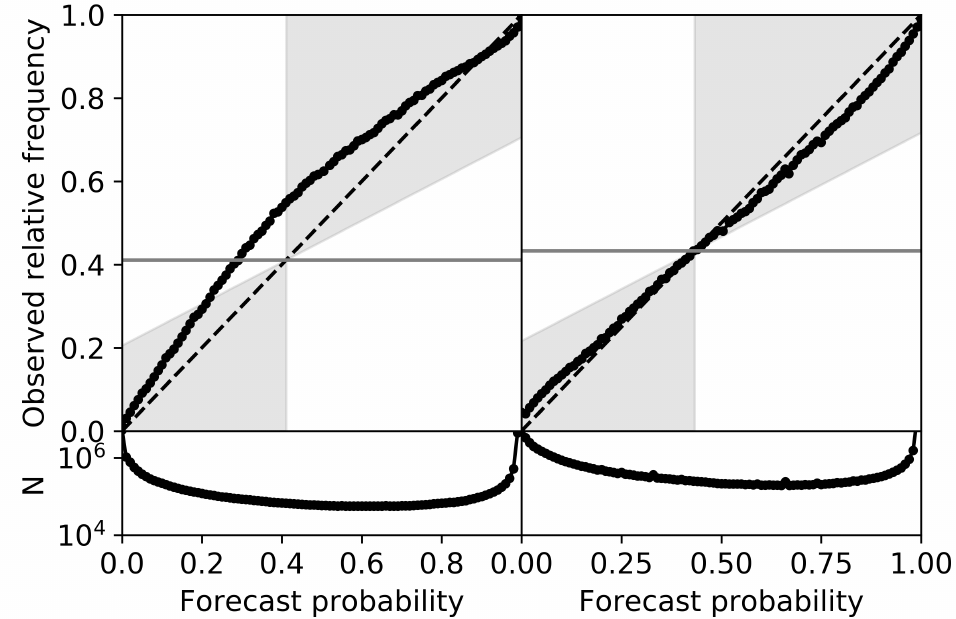
Figure 11. Reliability Diagram for exceeding the cumulative precipitation threshold of 0.1 mm/hr in the first half hour of the forecast. On the right is the plot for NN and on the left is the plot for STEPS . The lower subplots represent, on a logarithmic scale, the numerosity with which each forecast probability class was issued. The gray horizontal line corresponds to the frequency with which the event is observed (climate), while the shaded areas highlight the area where the ensembles have good reliability and thus predictive value from a probabilistic point of view.